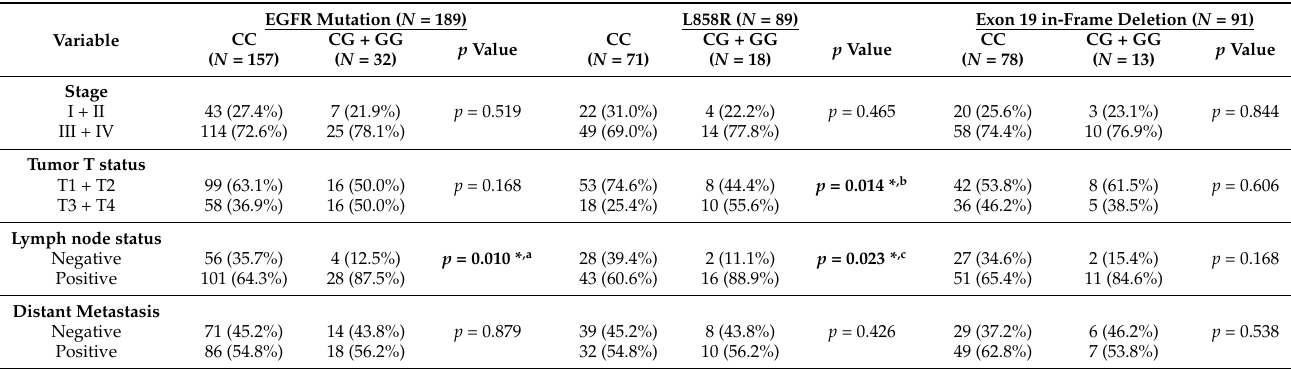
Table 4. Associations between polymorphic genotypes of WWOX (rs3764340) and clinicopathologic characteristics of lung cancer with EGFR mutation.